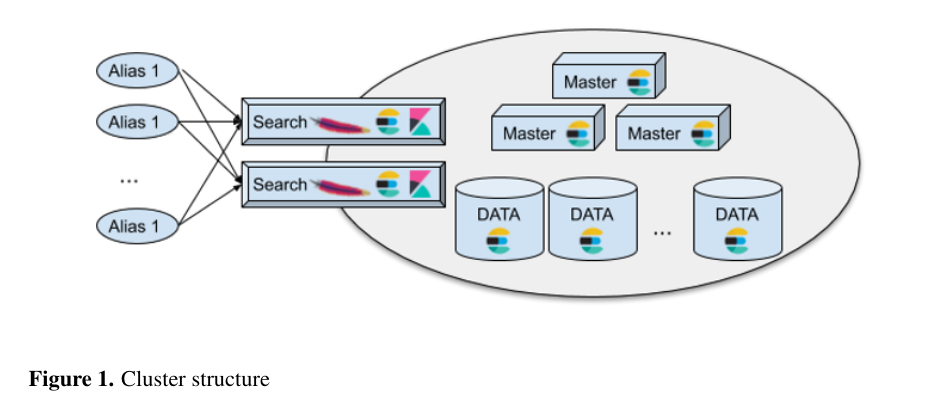
Figure 1. Cluster